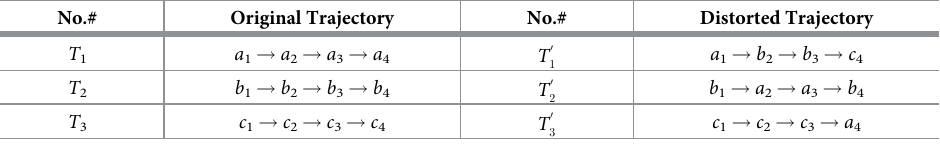
Table 1. Example of two trajectories exchanging reviews.